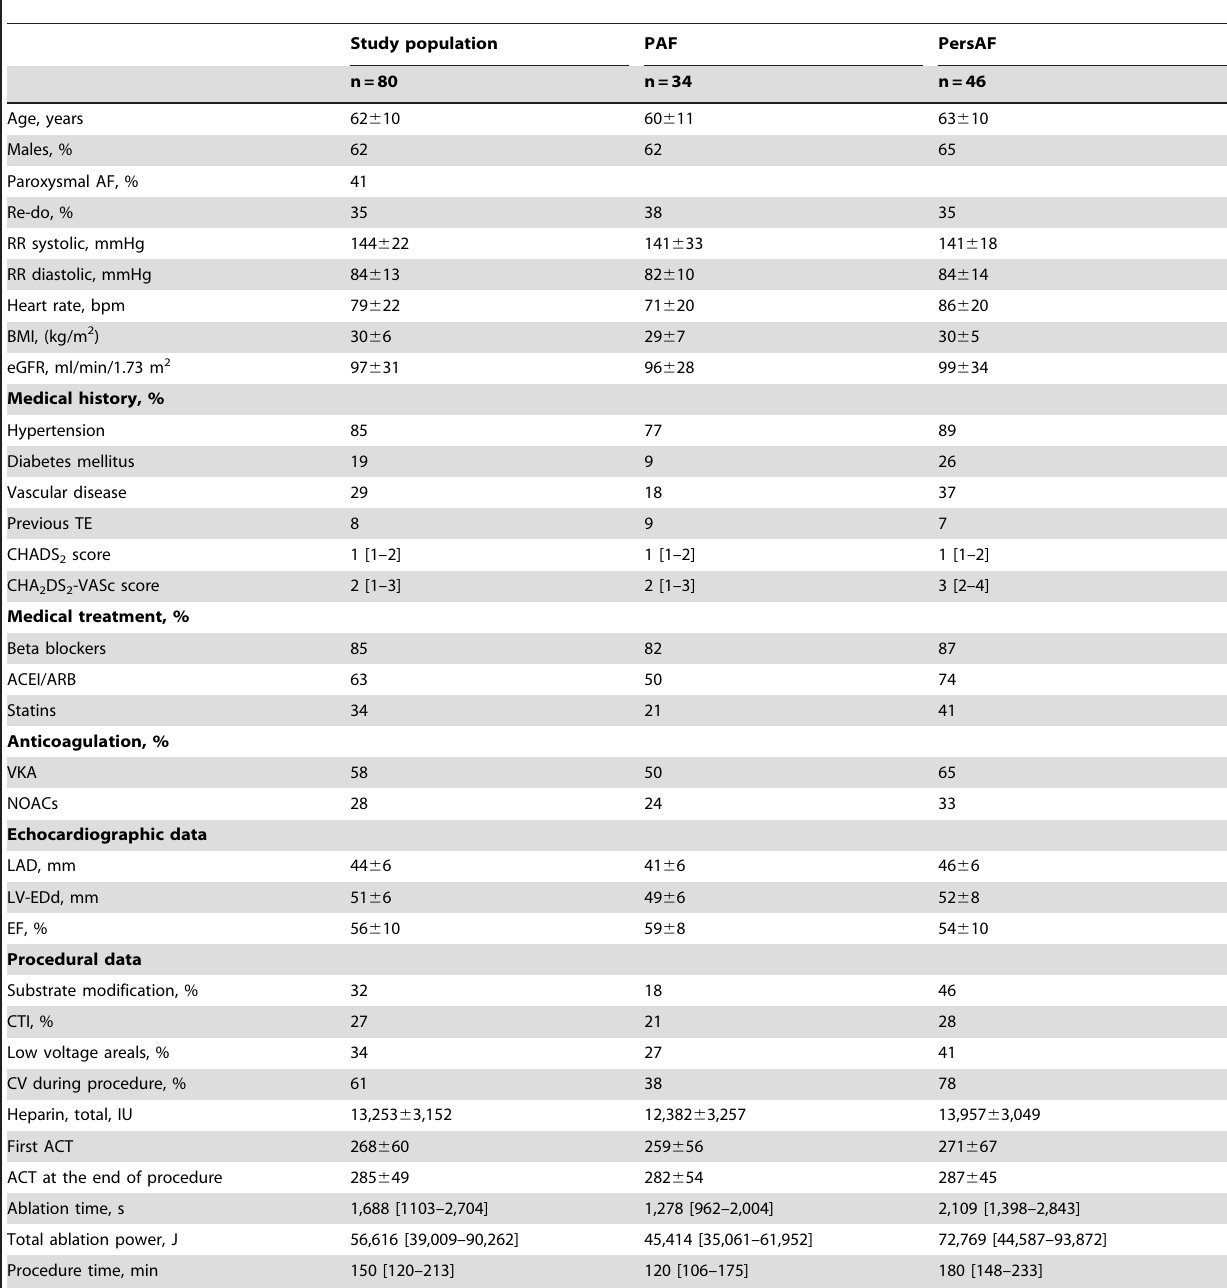
Table 1. Clinical, echocardiographic and procedural characteristic of the study